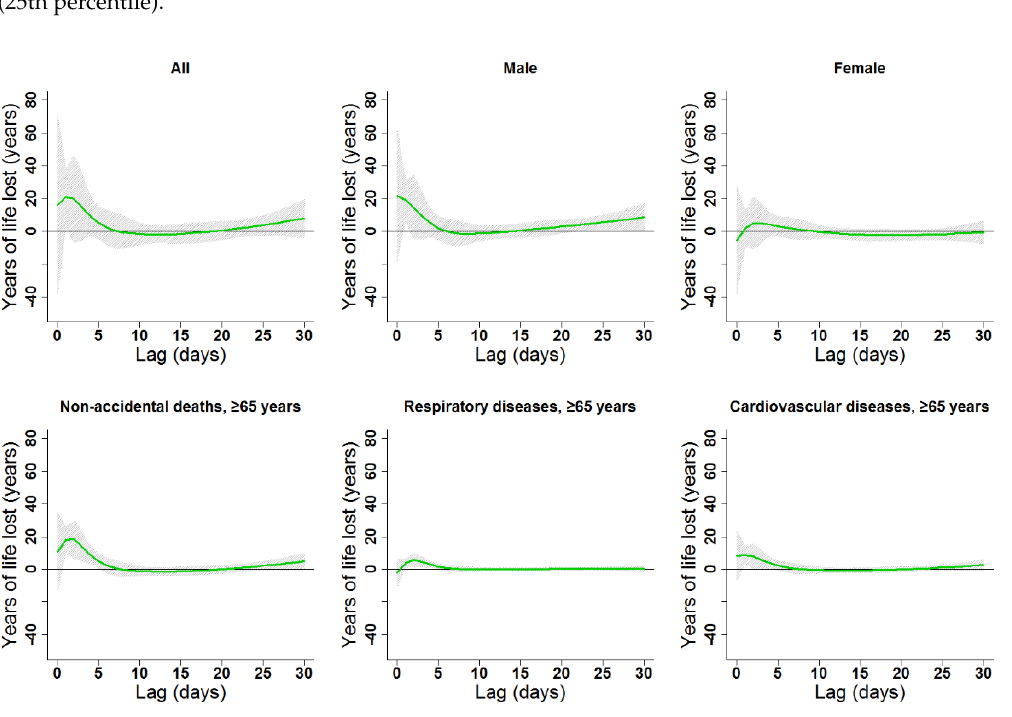
Figure 5. Lag patterns for single-day heat e ff ects on various subgroups in Lanzhou, China. The bold lines represent the e ff ect estimates, and the grey areas represent 95% confidence intervals. Heat e ff ects in the present study represented changes in YLL caused by higher temperatures from the 75th to the 99th percentile of the overall temperature distribution. The reference temperature was 19.7 ◦ C (75th